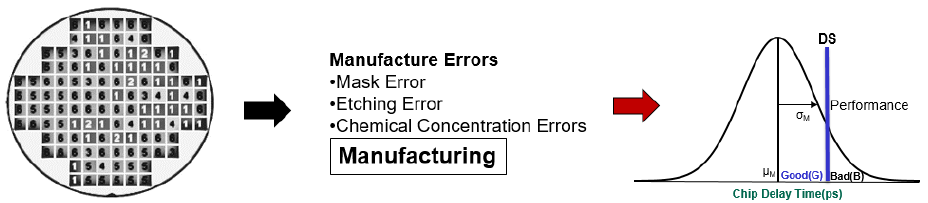
Figure 2. Effect of errors generated during the manufacturing process on the distribution of product electrical characteristics.